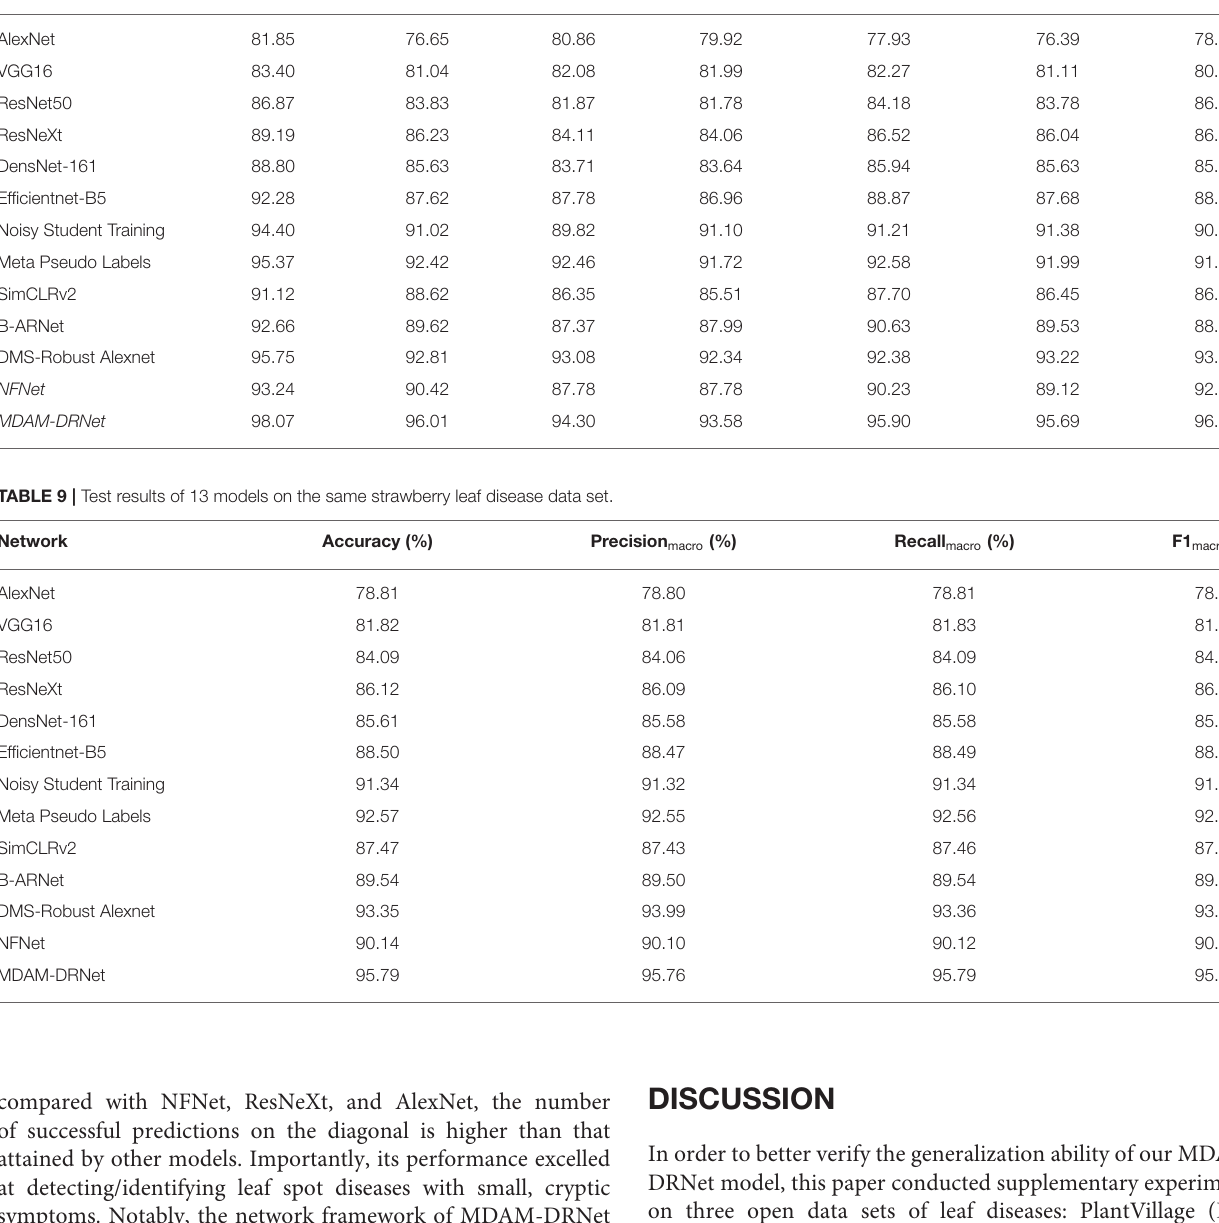
TABLE 8 | The recognition accuracy of 13 models for 7 categories of the same strawberry leaf disease data set. Network Healthy Powdery Leaf Botrytis Leaf leaves (%)